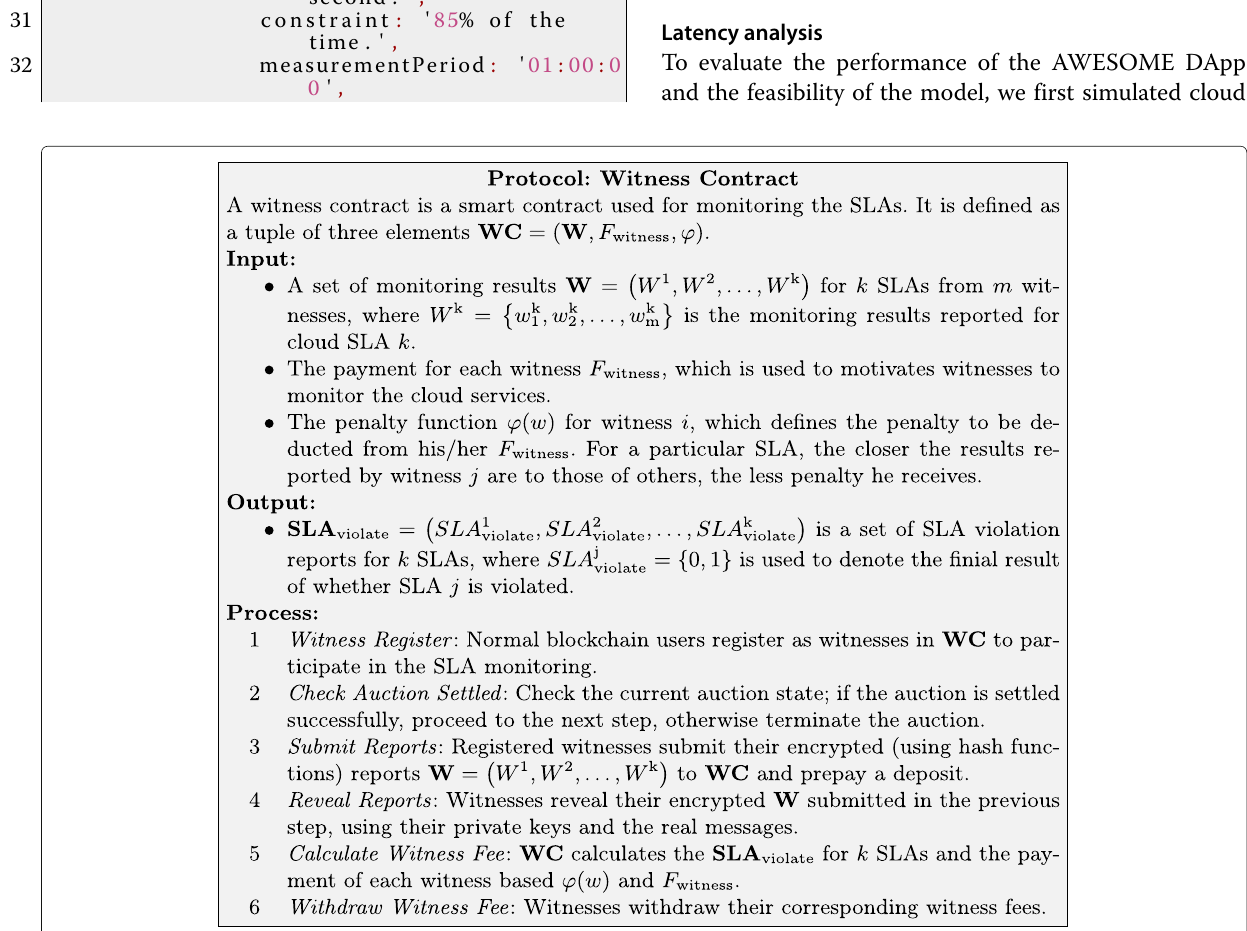
Fig. 5 Protocol: Witness